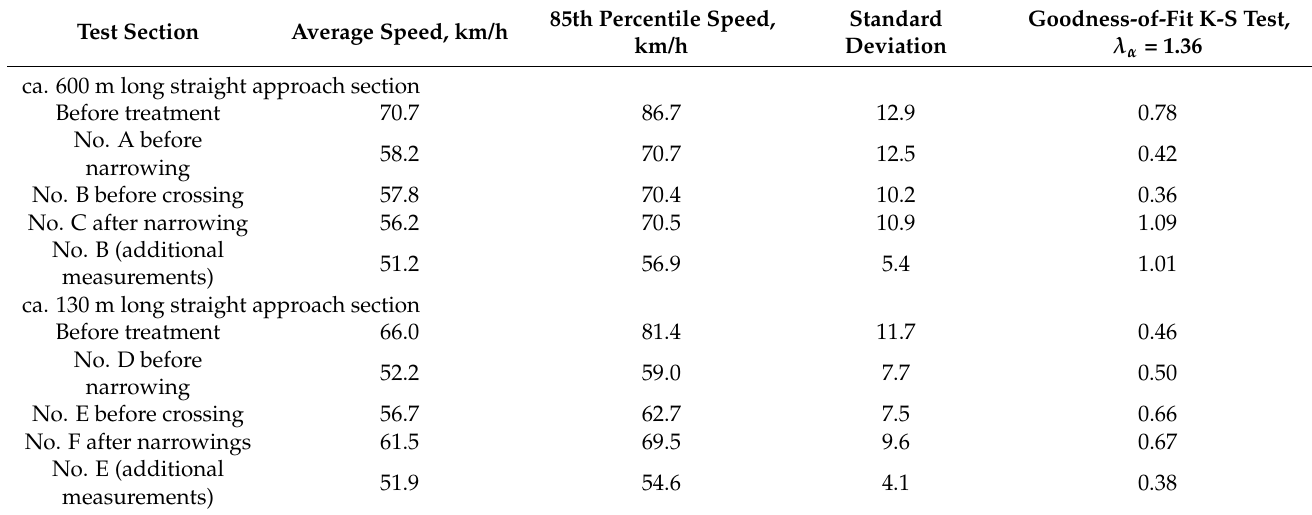
Table 1. Speed results: measured and obtained from the statistical tests.